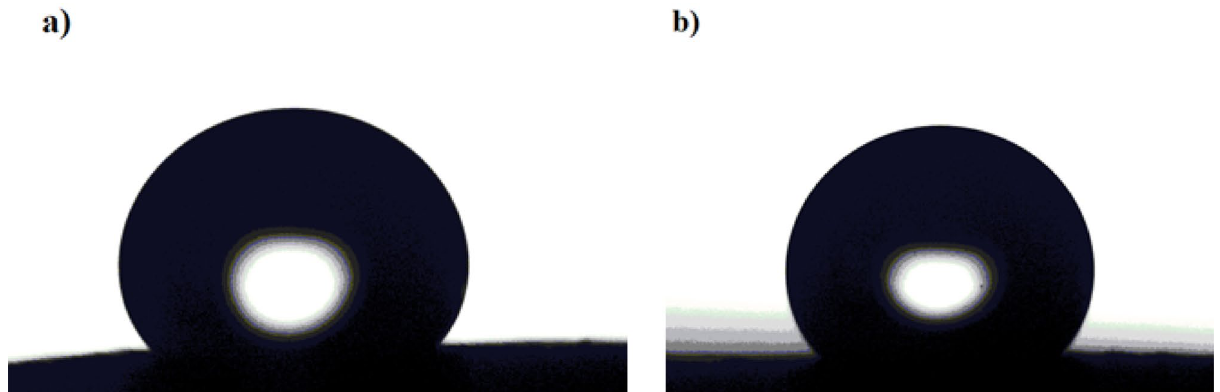
Figure 8. The shape of a water droplet on SHP coated steel by ( a ) Ni@G@MA, and ( b ) Ni@Cr-G@MA after submersion in a solution of pH 1.0 for one